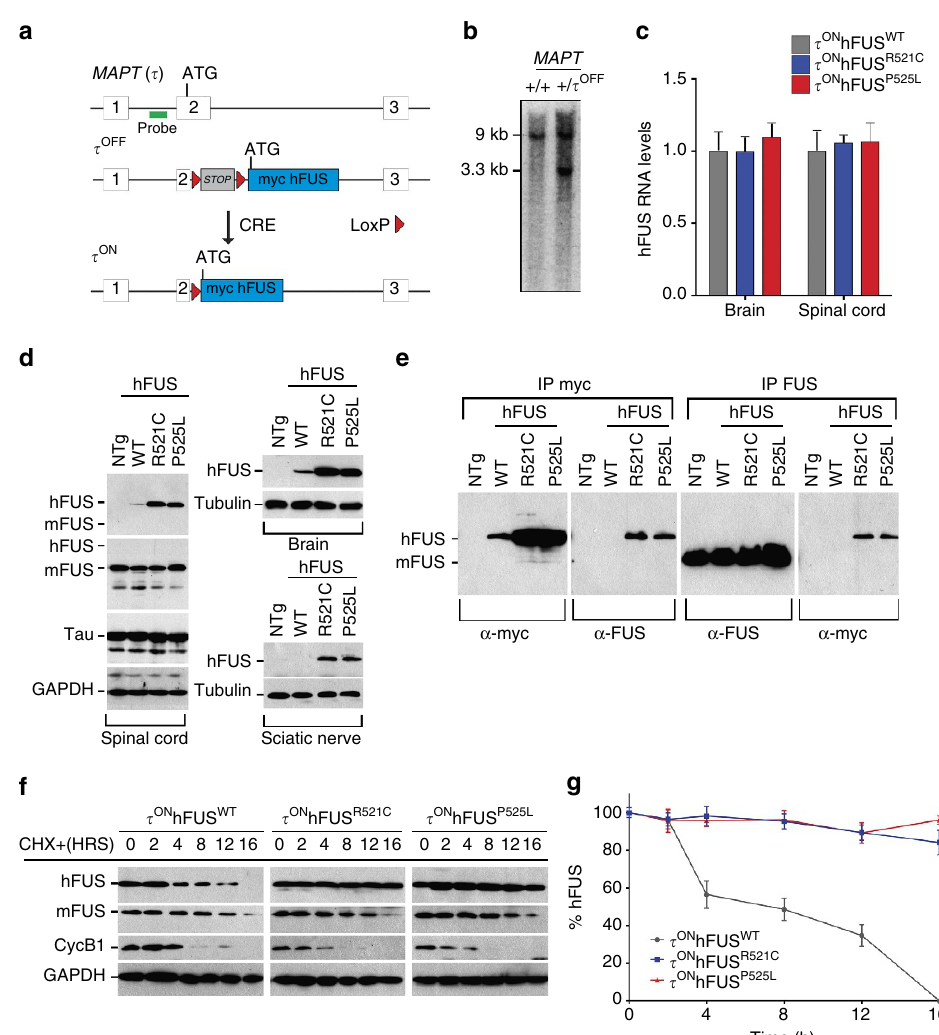
Figure 1 | Conditional expression of myc-tagged hFUS from the MAPT locus reveals increased stability of ALS mutant protein. ( a ) Organization of the endogenous ( t ) and targeted ( t OFF ) MAPT locus on mouse Chromosome 11. An hFUS expression cassette (light blue) was introduced into exon 2 of MAPT , replacing the endogenous start codon. Excision of the LOX-STOP-LOX transcriptional stop sequence by Cre-mediated recombination allows expression of the myc-tagged hFUS WT , hFUS R521C and hFUS P525L cDNAs from the t ON allele of the MAPT locus. ( b ) Southern blot analysis of targeted ES cell clones following Bam HI digestion and hybridization with a 5 0 external probe (green, a ). Wild-type ES cells (left, þ / þ ) display a 9.0-kb band. Targeted ES cells (right, þ / t OFF ) yielded a 3.3-kb band corresponding to the t OFF allele in addition to the 9.0-kb band corresponding to the untargeted allele at the MAPT locus. ( c ) RT–qPCR analysis of hFUS transcripts in total brain and total spinal cord (p90, N ¼ 4). Data are represented as mean and s.e.m. ( d ) Western blot analysis of total spinal cord, brain and sciatic nerve extracts. 7x myc-tagged hFUS migrated at a higher molecular weight (90kDa) relative to endogenous mouse FUS (73kDa). Immunoblotting with anti-FUS antibody did not detect myc-hFUS. All mutants analysed were heterozygous for the t ON hFUS alleles (with the exception of Supplementary Fig. 4A–C) and tau expression was maintained in these animals. ( e ) Immunoprecipitation of P90 mouse spinal cord extracts with anti-myc or anti-FUS antibodies. myc-hFUS bands were detected with an anti-FUS antibody following immunoprecipitation with an anti-myc antibody. ( f ) Western blot analysis of cyclohexamide (CHX)-treated embryonic stem cell-derived motor neurons (ESMNs). At 16h post CHX treatment, myc-hFUS was no longer detected with anti-myc antibody in cells derived from t ON hFUS WT animals but persisted in t ON hFUS R521C and t ON hFUS P525L samples. Levels of endogenous mouse FUS detected with anti-FUS antibody were similarly decreased in all samples. CyclinB1 was used as an internal positive control for CHX treatment efficacy. ( g ) Quantification of myc-hFUS levels, normalized to myc-hFUS levels at 0h, in CHX-treated ESMNs. Data are represented as mean and s.e.m. of N ¼ 3